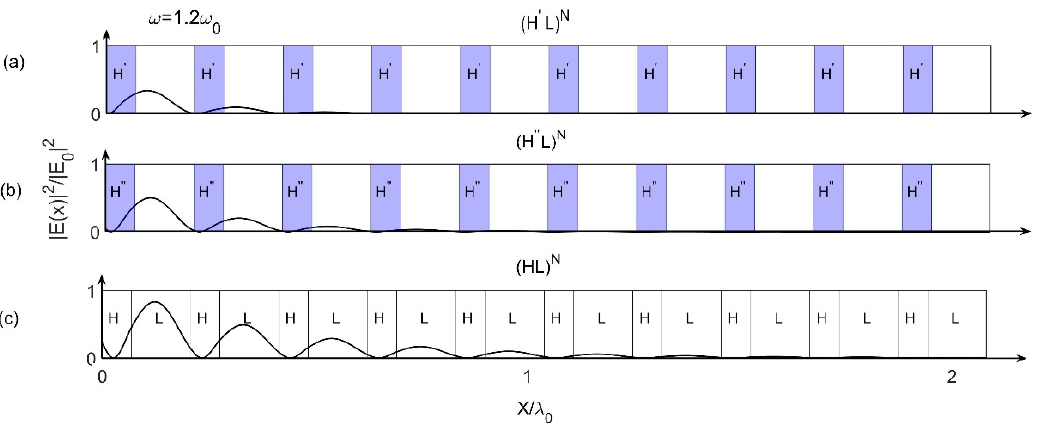
Figure 3. Field distributions for ω = 1.2 ω 0 and k = − 10.4 at incident angle θ = 0 ◦ for ( a ) Model 1 ( H (cid:48) L ) N , ( b ) Model 2 ( H (cid:48)(cid:48) L ) N and ( c ) reference model ( HL ) N , respectively.